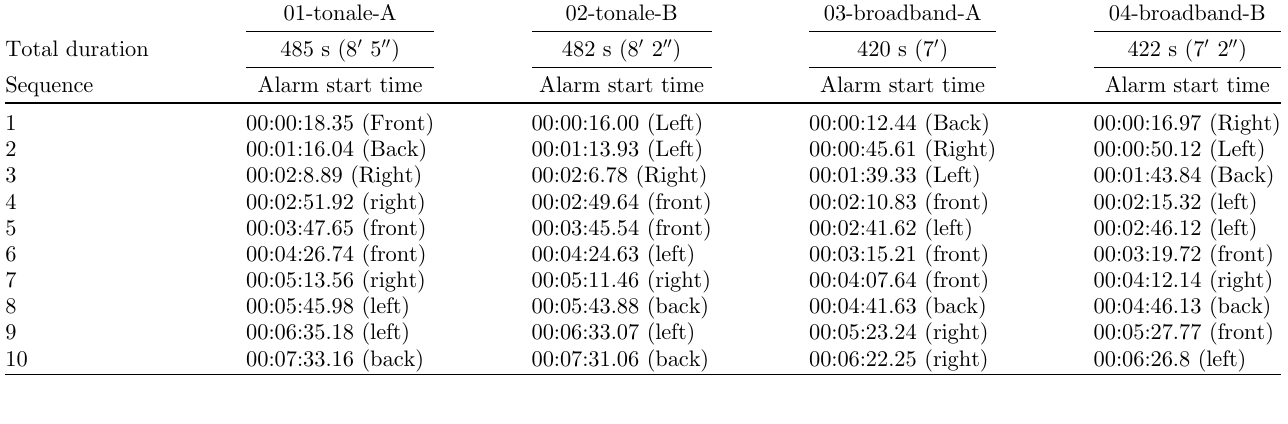
Table 1. Sequences of the alarms used during the experiments conducted at the GAUS and at the LVA. The alarm start times are formated using the notation HH:mm:ss.SS.